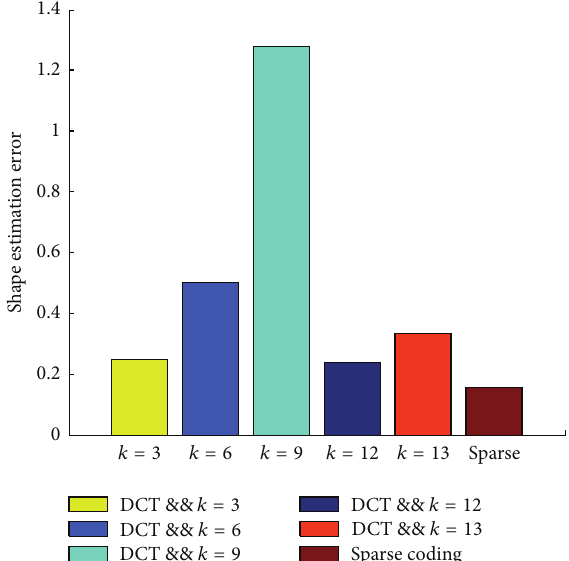
Figure 2: Shape estimation error on the “Yoga” motion sequence. From left to right, each column indicates different performances when the sizes of DCT basis are 3, 6, 9, 12, and 13, respectively, and the most right column gives the result of sparse methods (better viewed in